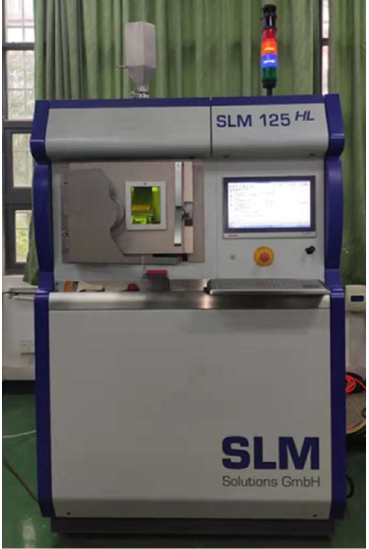
Fig. 2. SLM-125HL metal 3D